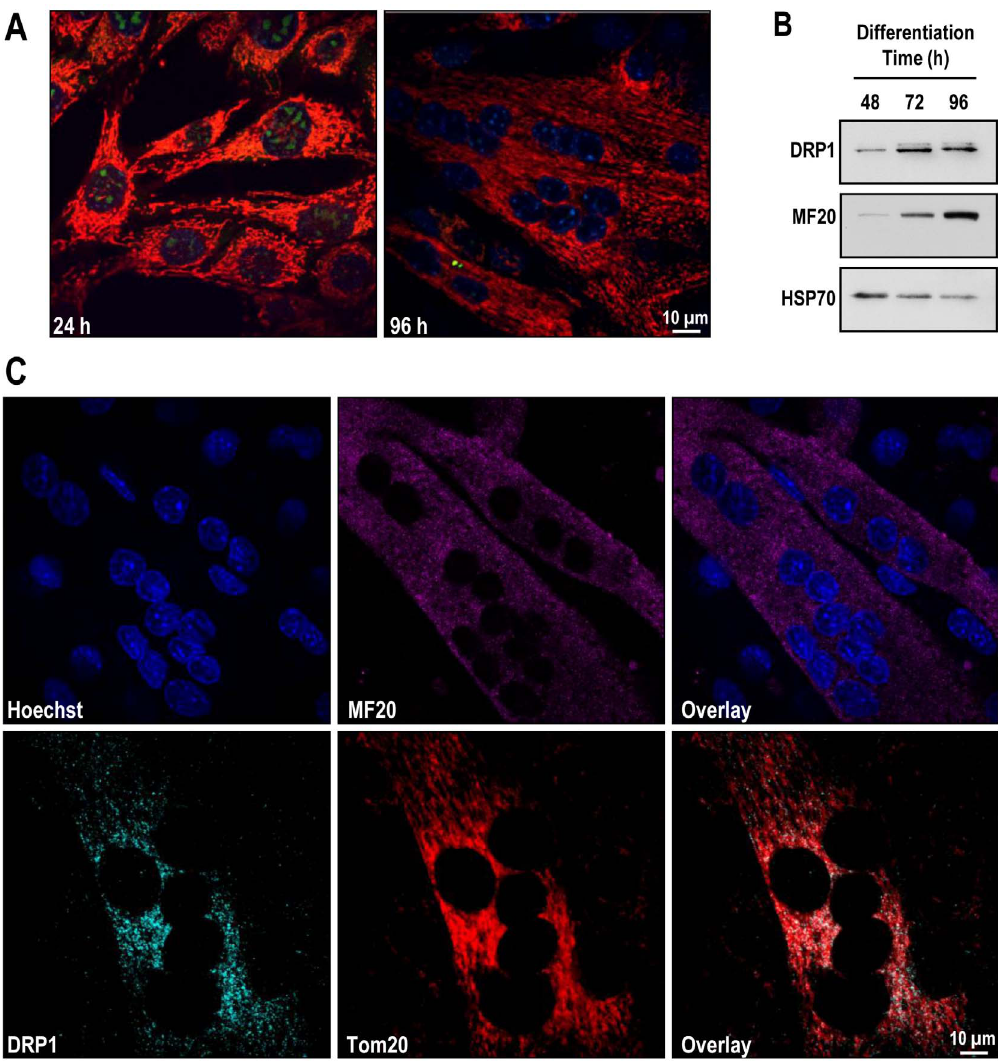
Figure 1. C2C12 myoblasts differentiate into myotubes expressing contractile apparatus and mitochondrial fission machinery. C2C12 myoblasts were cultured and induced to differentiate for 24–96 h at 37 u C in an atmosphere of 10% CO 2 . Panel A: C2C12 myoblasts differentiate into myotubes. Cells were plated onto coverslips and allowed to reach 70–80% confluence before inducing differentiation. Live images were captured at 405 nm (to visualize DNA, blue), 515 nm (to visualize oxidized hET, green) and 633 nm (to visualize mitochondira, red) on a laser- scanning confocal microscope. Panel B: Immunoblots confirming upregulated expression of mitochondrial fission protein DRP1 and contractile protein myosin heavy chain during differentiation in C2C12 myotubes. Cells were harvested, and 50 m g of protein (pooled from 5 separate experiments) were processed for gel electrophoresis. Primary antibodies used were against DRP1, MF-20, and HSP70. Panel C: Translocation of DRP1 to the mitochondrial membrane in C2C12 myotubes. Differentiated C2C12 myotubes were fixed, and incubated with primary antibodies against MF20, DRP1 and/or Tom20 and then corresponding Alexa Fluor secondary antibodies. Confocal microscopy images were captured as described